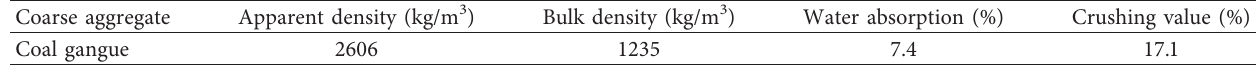
Table 3: Basic physical properties of coal gangue.